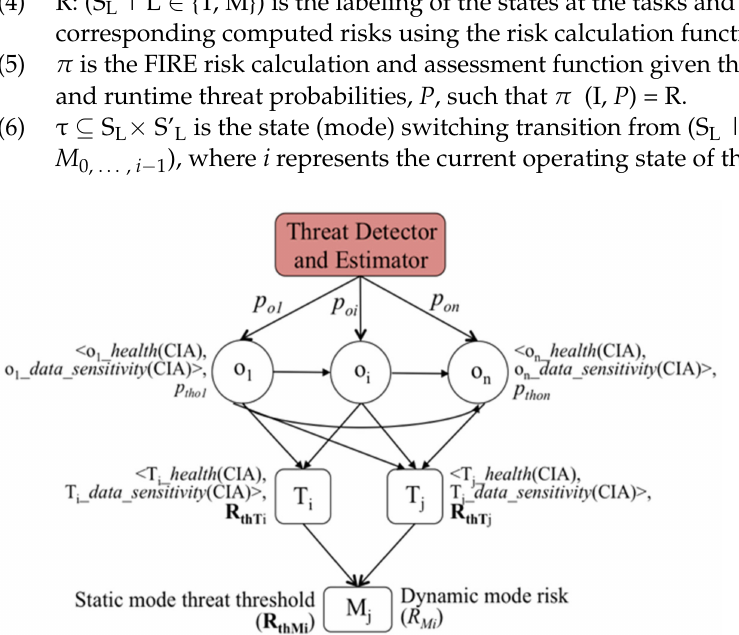
Figure 3. Illustration of the HCFR